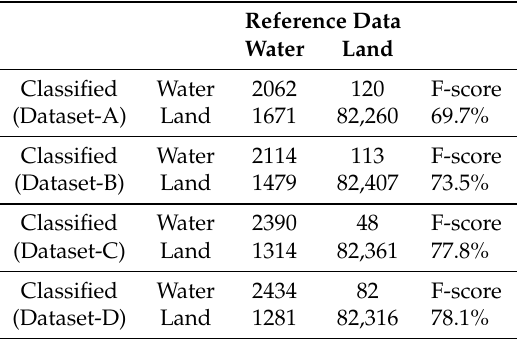
Table 3. Error matrices derived from images taken on 22 July 2018.